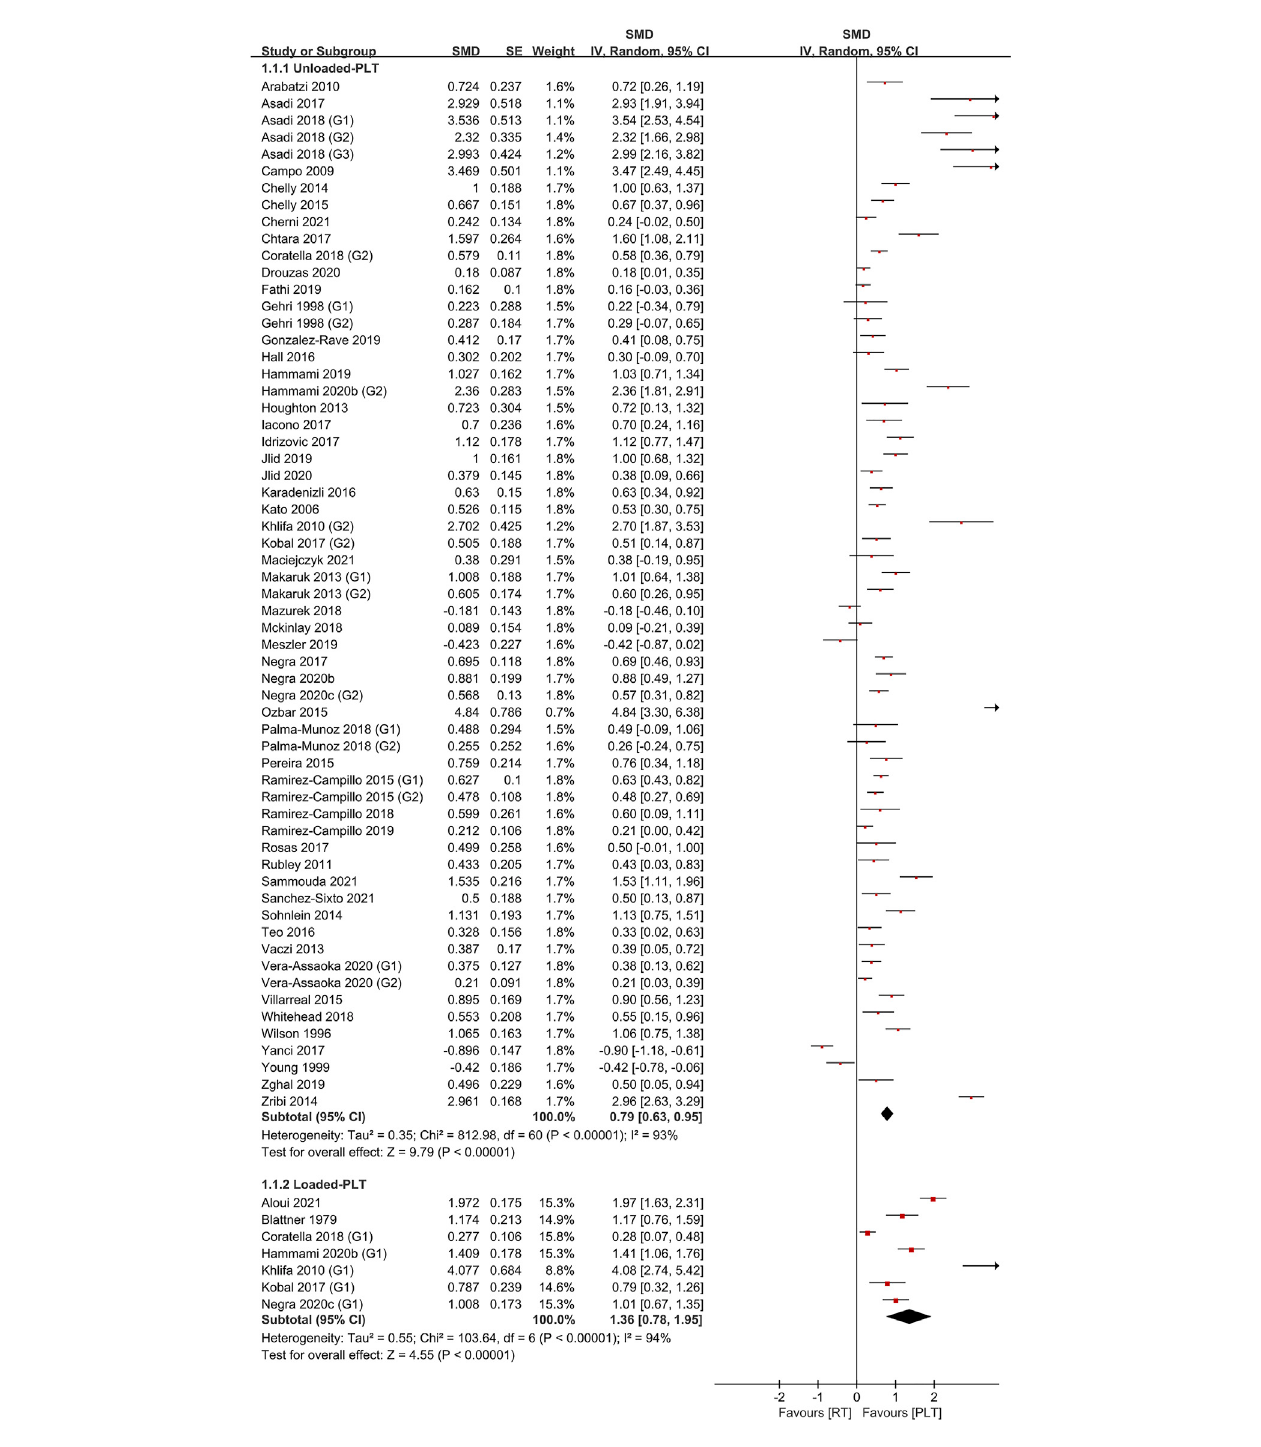
FIGURE 2 Effects of plyometric training (PLT) on jump